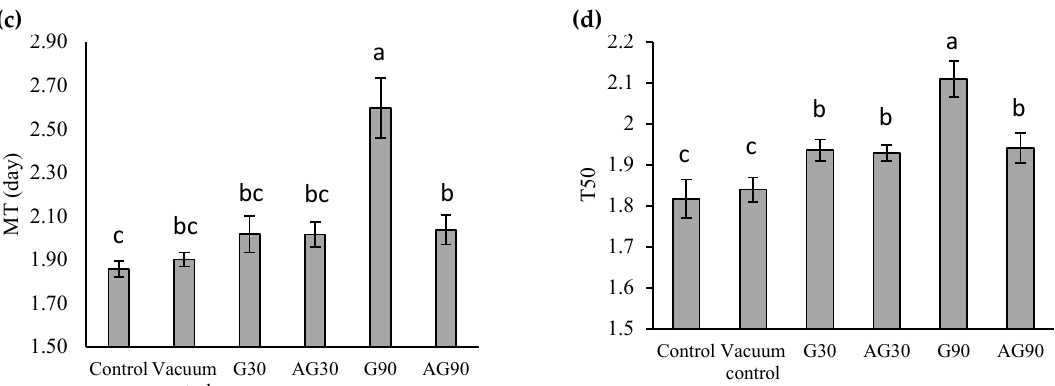
Figure 7. Final germination rate—G r ( a ), mean germination rate—MR ( b ), mean germination time—MT ( c ), and median germination time—T50 ( d ) of untreated (Control) seeds, seeds exposed to vacuum (Vacuum control), and CP-treated wheat seeds in the glow regime for 30 (G30) or 90 s (G90), and the afterglow regime for 30 (AG30) or 90 s (AG90). Displayed values are the mean ± SE of three replications. Different letters (a–d) indicate statistically significant differences among treatments according to Duncan’s test ( p < 0.05).